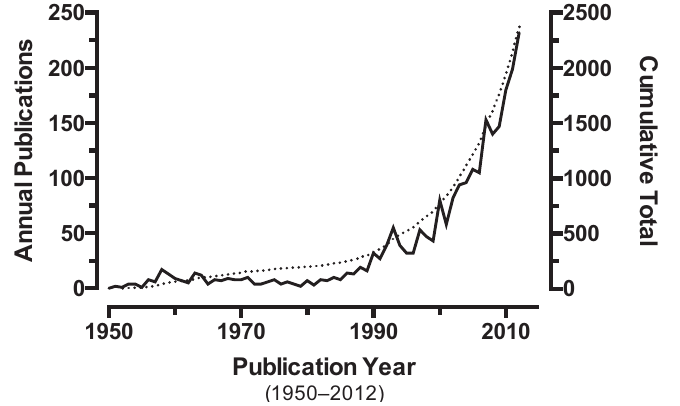
Figure 1. The annual number of scientific papers published with “insecticide AND resistance” in the title/abstract abstracted in PubMed. The overlaid curve (dashed line) shows the cumulative total number of publications on insecticide